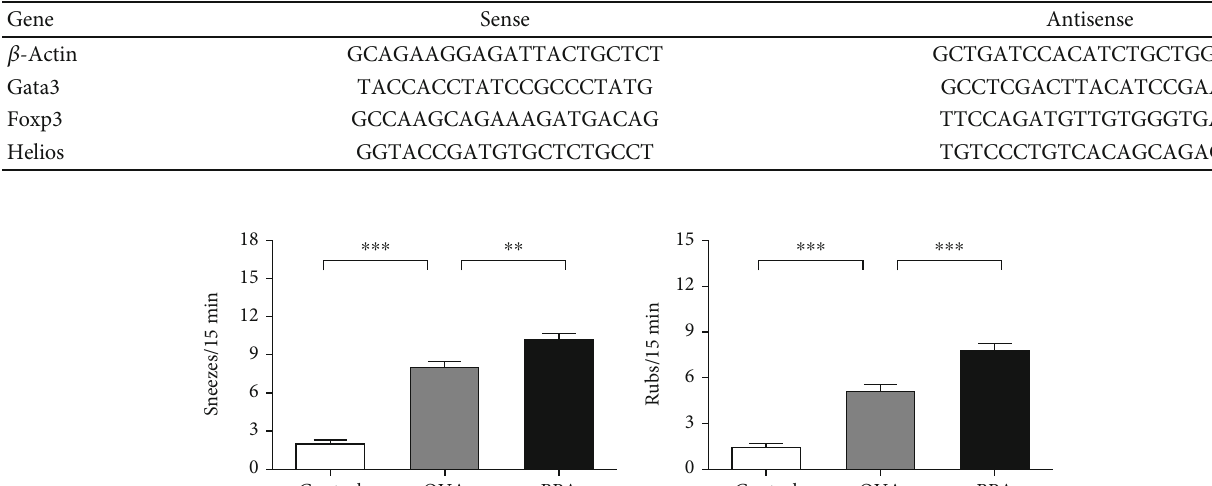
Table 1: Primer sequences for quantitative real-time PCR.